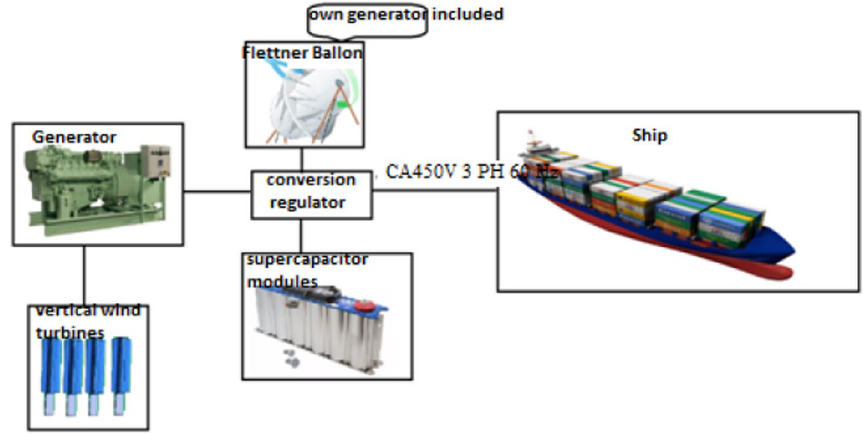
Fig. 16 Scheme for connecting the hybrid energy system to a container ship (Bergeson and Kent 1985; Craft et al.